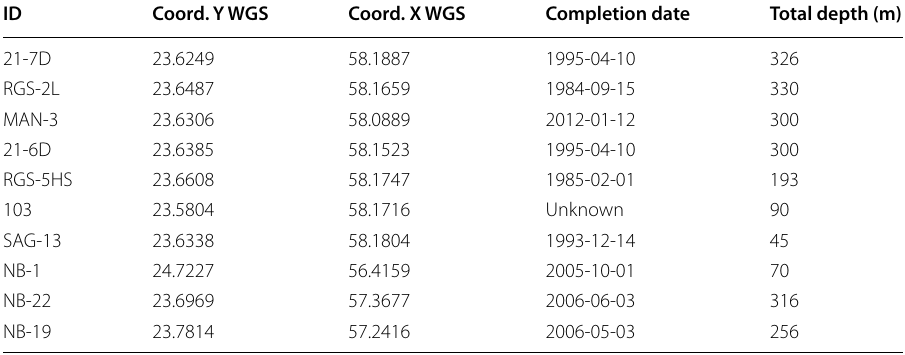
Table 1 Coordinates, completion date and total depth of wells, which were used for T-logging and wells of which T-logs were provided by the MRMWR (NB-1, NB-22, NB-19) ID Coord. Y